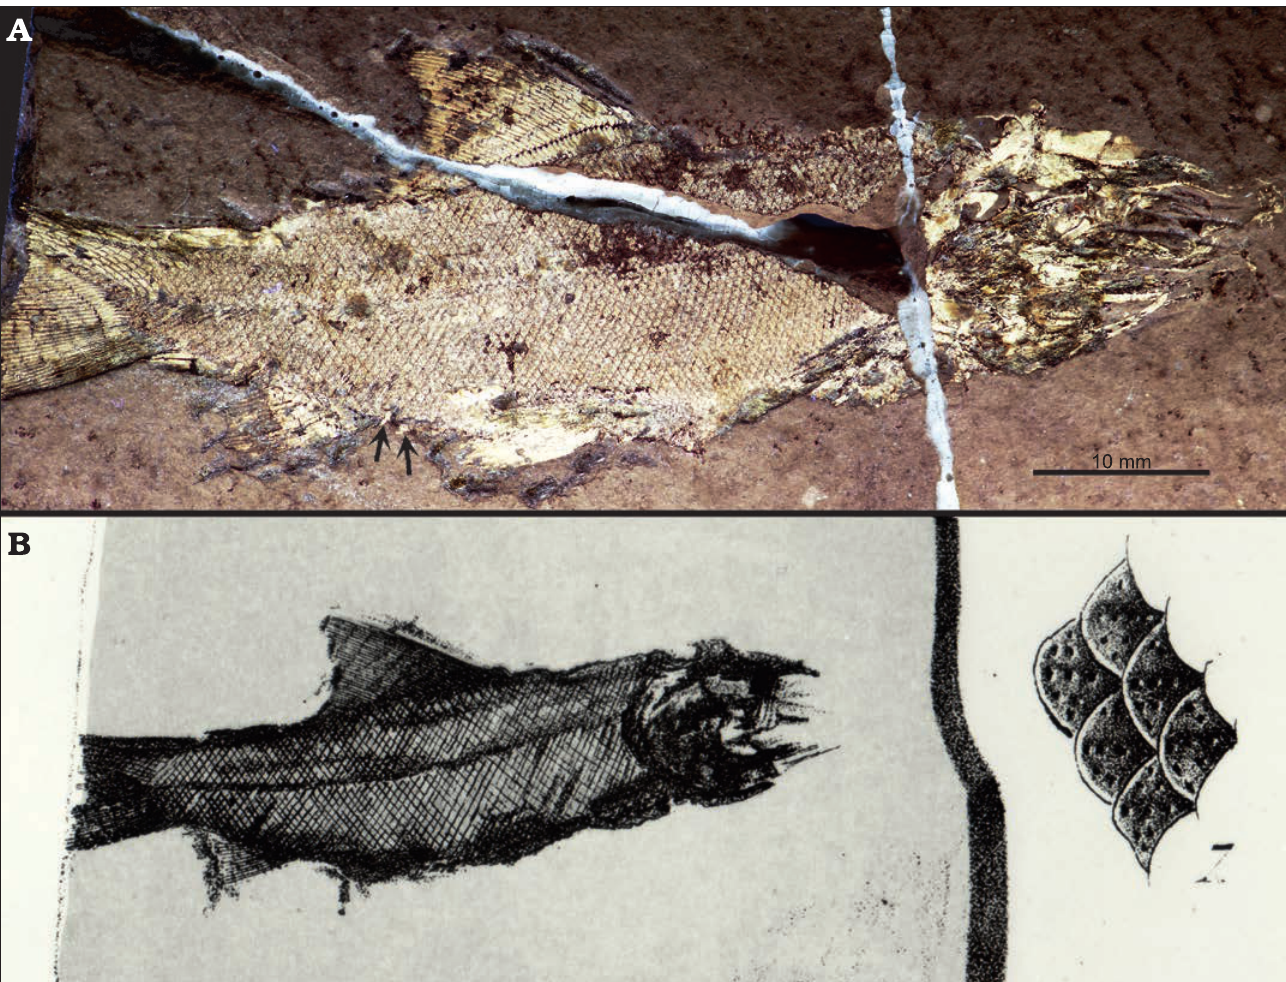
Fig. 2. Holotype of the chondrostean fish Coccolepis bucklandi Agassiz, 1843 from the Tithonian, Upper Jurassic of the Solnhofen Lagerstätte, Bavaria, Germany. A . MHNN-FOS 361 (TL ~ 75 mm), photograph taken under UV-light, courtesy of Thierry Malvesy (MHNN). Arrows point to fragmentary remains of the preanal scutes. B . Original illustration of Agassiz (1843: pl. 36: 6). Scan courtesy of Eric Hilton (Virginia Institut of Marine Science, Gloucester Point, Virginia,